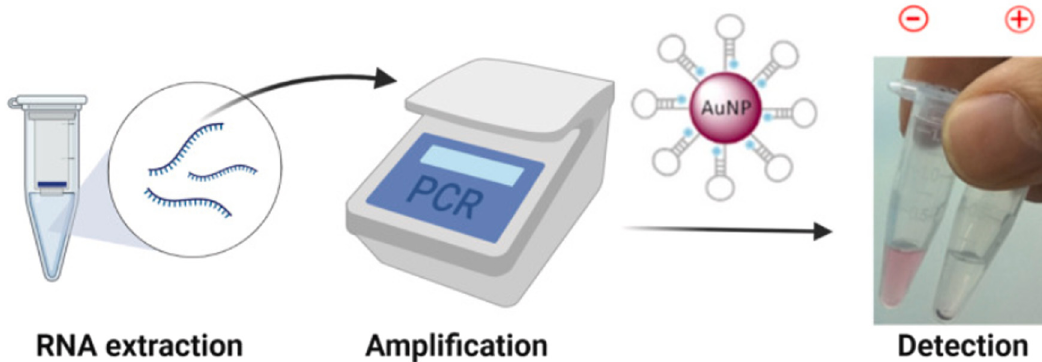
Figure 16: Colorimetric sensor based on gold nanoparticles [ 108 ] .